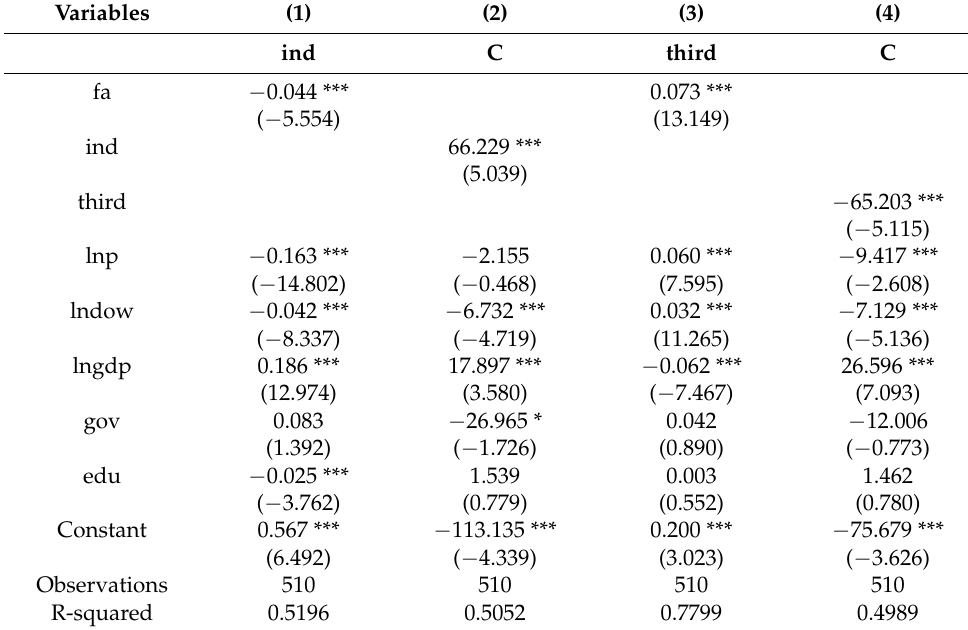
Table 5. Inspection of intermediary